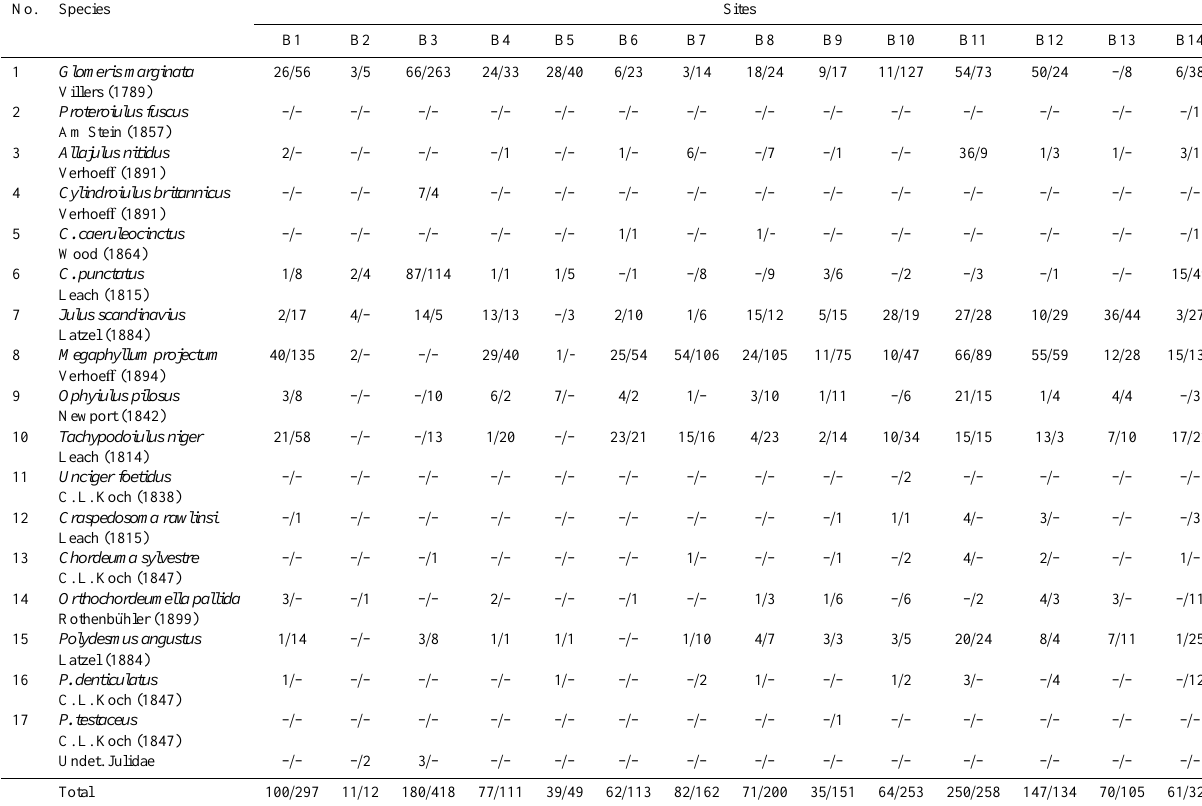
Table 2. Number of Diplopoda individuals by species in beech habitats (B sites): 2009 / 2010. No.